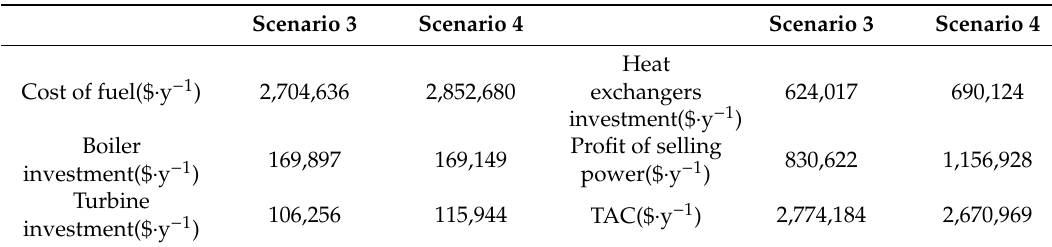
Figure 5. Structure with minimum TAC of Scenario 4. Table 3. Results of Scheme 2.